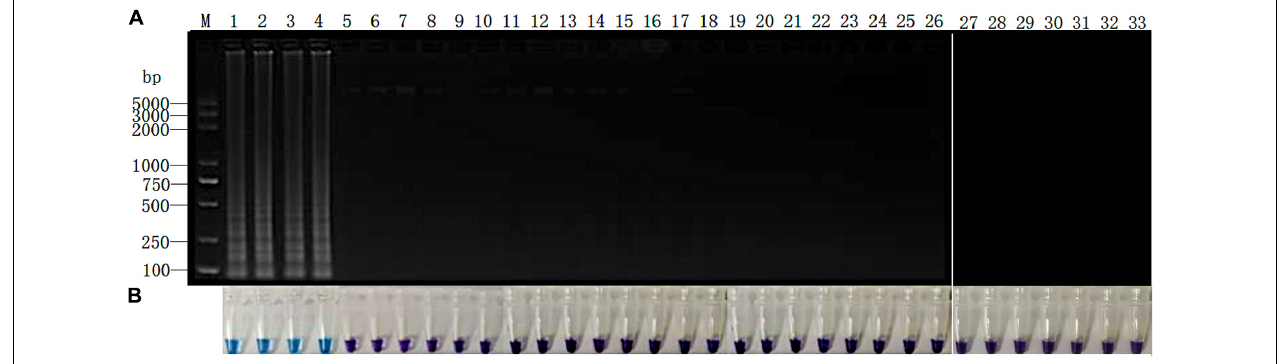
FIGURE 6 | Detection of P. vexans in infected ramie roots. (A) Detection of LAMP products by 2% agarose gel electrophoresis. (B) Detection of LAMP products detected by HNB. Lanes 1–4, P. vexans ; lanes 5 and 6, P. spinosum ; lanes 7 and 8, P. irregulare ; lanes 9 and 10, P. sylvaticum ; lanes 11 and 12, P. helicoides ; lanes 13 and 14, P. ultimum ; lanes 15 and 16, P. myriotylum ; lanes 17 and 18, P. litorale ; lanes 19 and 20, P. oligandrum ; lanes 21 and 22, P. heterothallicum ; lanes 23 and 24, P. carolinianum ; lanes 25 and 26, P. guiyangense ; lanes 27 and 28, P. aphanidermatum ; lanes 29 and 30, P. recalcitrans ; lanes 31 and 32, CK. Lane 33, negative